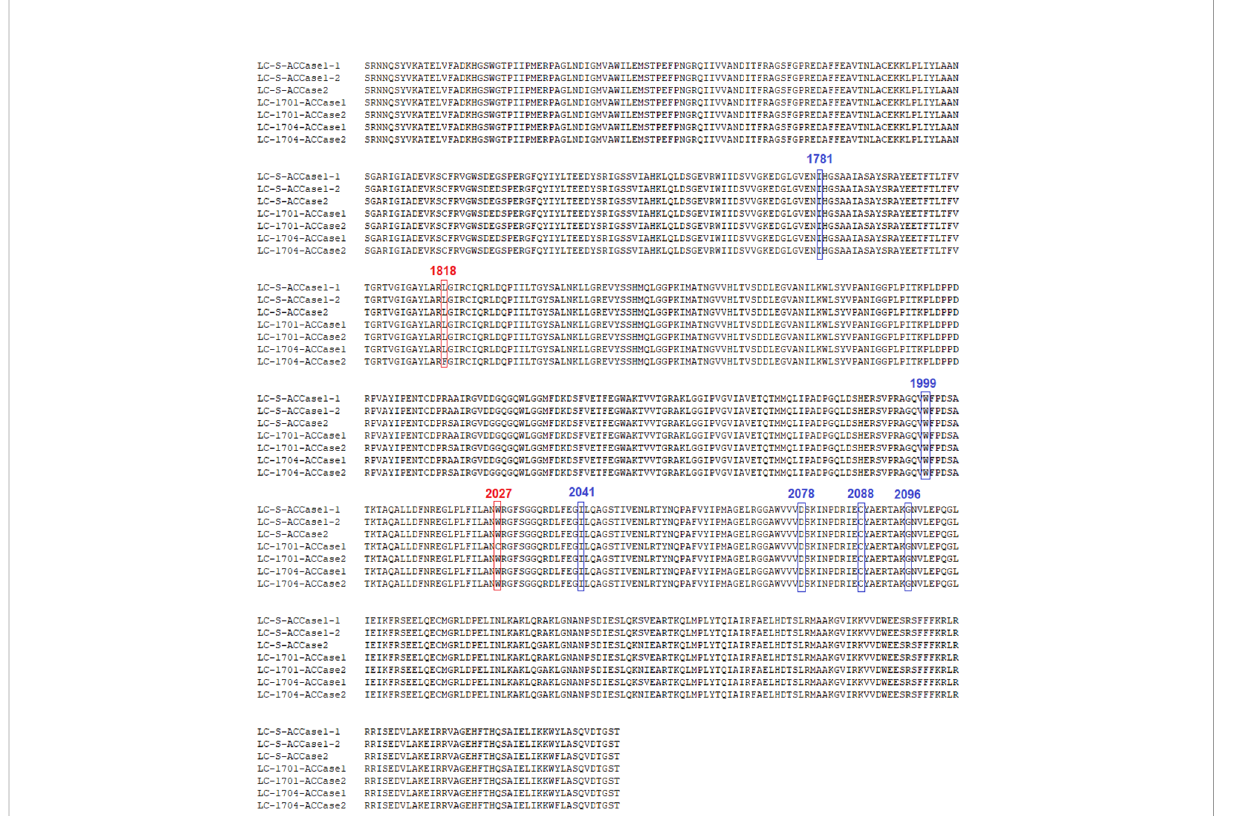
FIGURE 2 Alignment of the amino acid sequences of partial ACCase in susceptible and resistant Leptochloa chinensis populations. Three types of LC-S ACCase are designated as LC-S-ACCase1-1, LC-S-ACCase1-2, and LC-S- ACCase2. Two types of LC-1701 are designated as LC-1701-ACCase1 and LC-1701- ACCase 2. Two types of LC-1704 are designated as LC-1704-ACCase1 and LC-1704-ACCase2. The red boxed regions represent the mutation sites in the resistant populations. The blue boxed regions represent the other known six resistance-conferring mutation